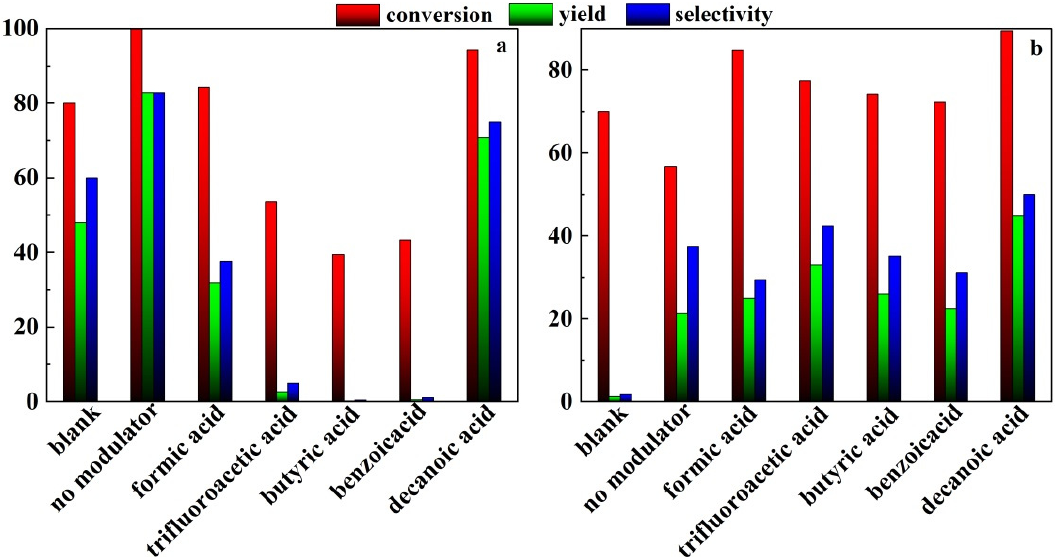
Figure 6. Effect of modulator type on HMF production from ( a ) fructose and ( b ) glucose.